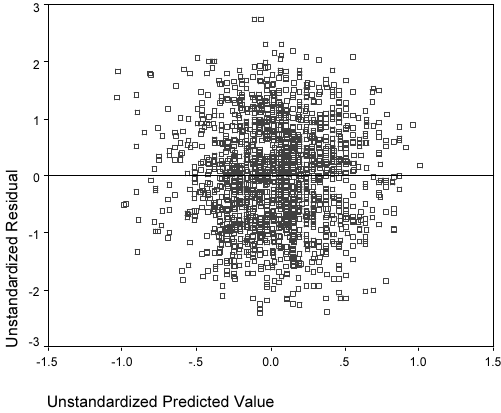
Figure 1: Real unstandardized residuals plotted against the weighted linear combination of the two cognitive